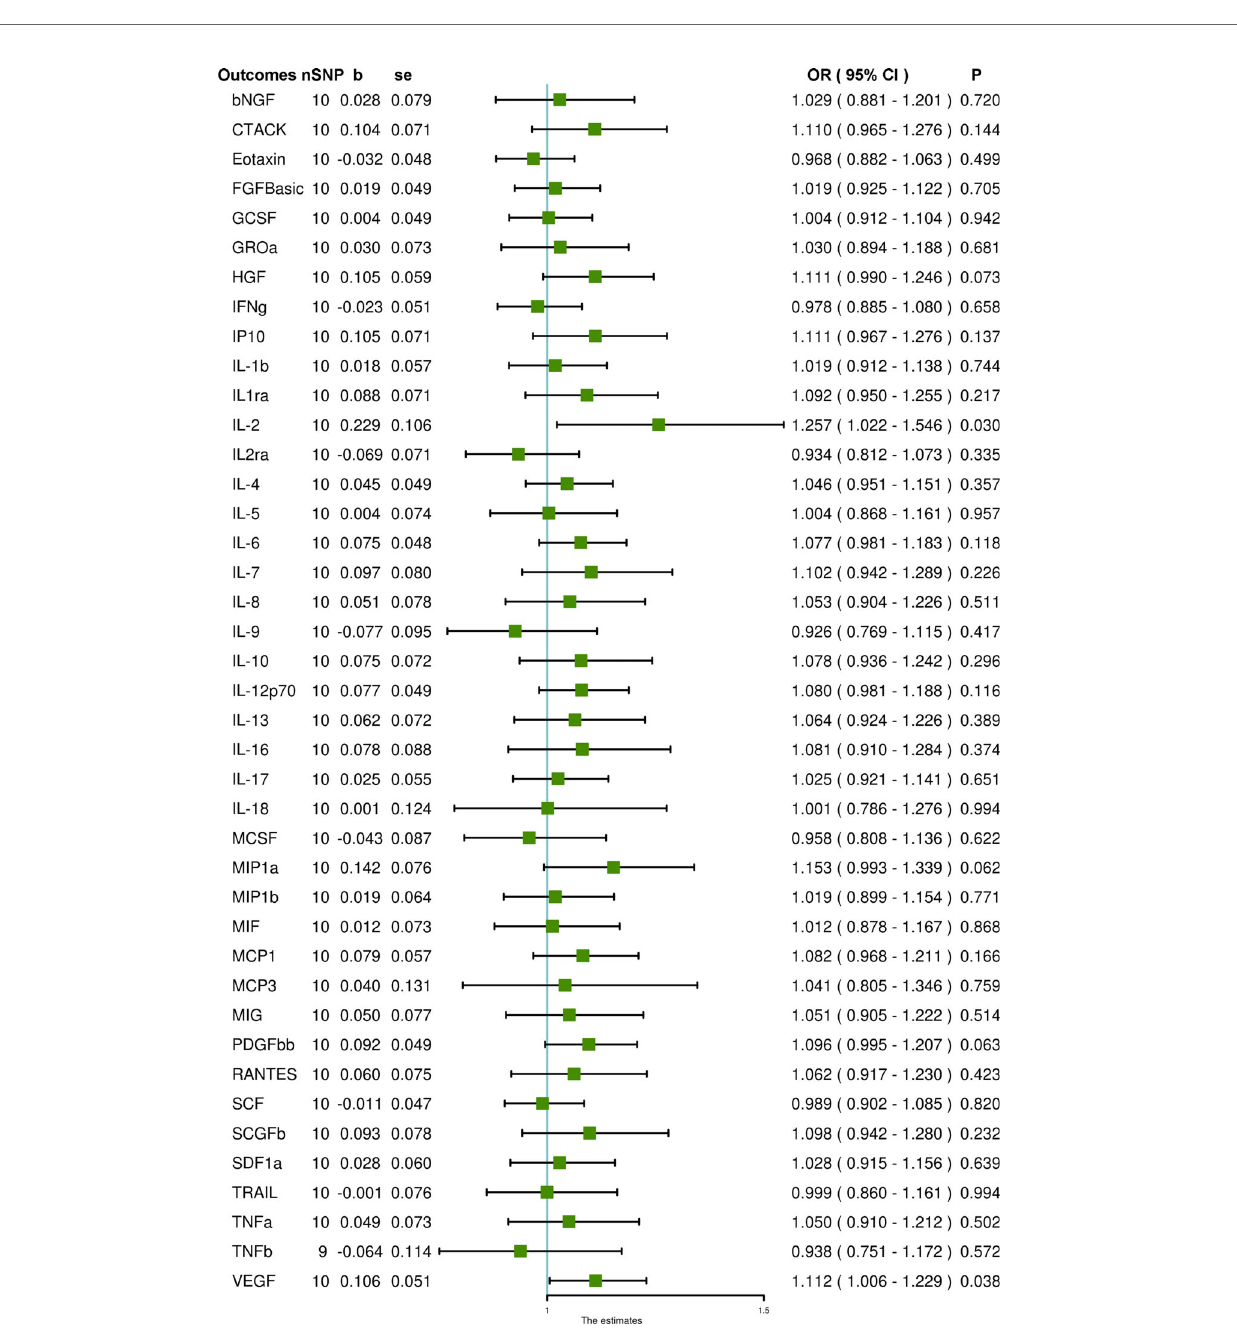
Frontiers in Endocrinology |